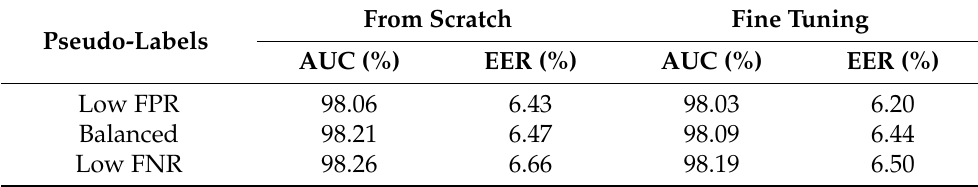
Table 4. AUC (%) and EER (%) for FS02 development partition using the pseudo-label domain transfer setup training a new neural network from scratch and fine tuning the baseline neural